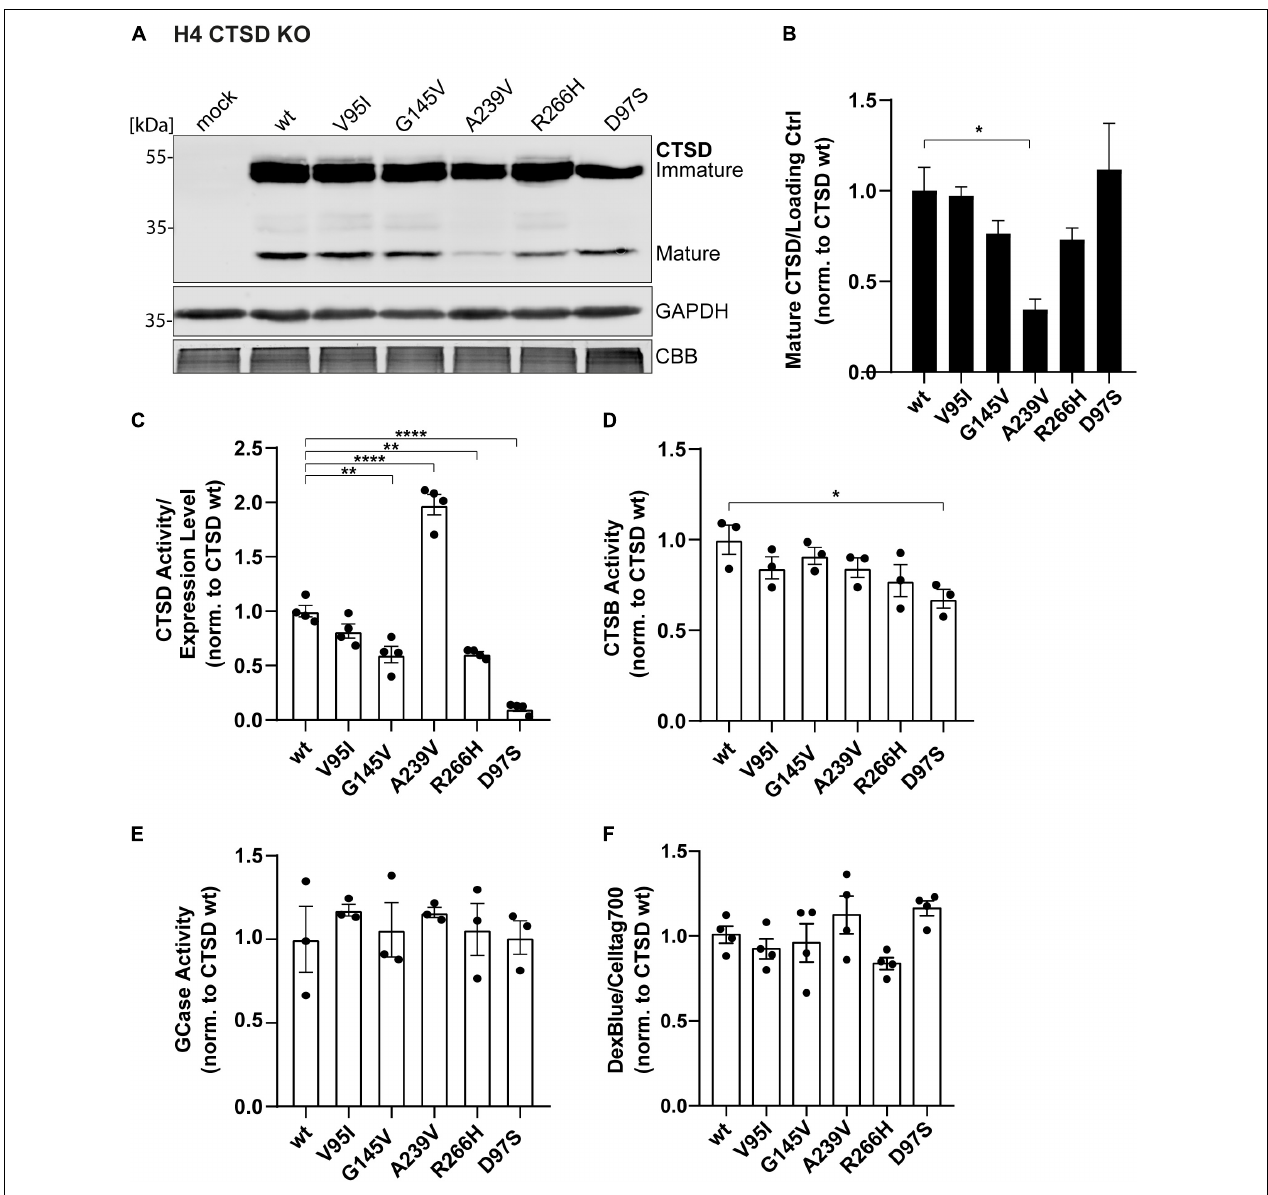
FIGURE 3 | Cellular and functional analyses of PD-associated CTSD variants in H4 CTSD KO cells. (A) Representative immunoblot of CTSD wt, PD-associated CTSD variants (V95I, G145V, A239V, and R266H) and catalytically inactive mutant D97S overexpressed in neural-like H4 cells deficient for CTSD (CTSD KO). GAPDH and CBB were used as a loading control. (B) Analysis of CTSD protein expression by quantification of signal intensities of mature CTSD protein bands normalized to loading control (GAPDH) and expressed relative to CTSD wt ( n = 4). (C) CTSD activity assay measured within H4 CTSD KO cell extracts and normalized to CTSD wt ( n = 4). (D) Cathepsin B activity measured in whole cell lysates by fluorogenic peptide cleavage assays and normalized to CTSD wt ( n = 3). (E) β -Glucocerebrosidase (GCase) activity measured in whole cell lysates and normalized to CTSD wt ( n = 3). (F) Lysosomal homeostasis was assessed by measuring lysosomal mass using dextran blue (DexBlue) in a plate reader approach normalized to the cell marker celltag700. The values are shown as ratio to CTSD wt ( n = 4). All statistical analyses were performed by using a one-way ANOVA followed by a Tukey’s multiple comparison test. * p < 0.05, ** p < 0.01, **** p < 0.0001.